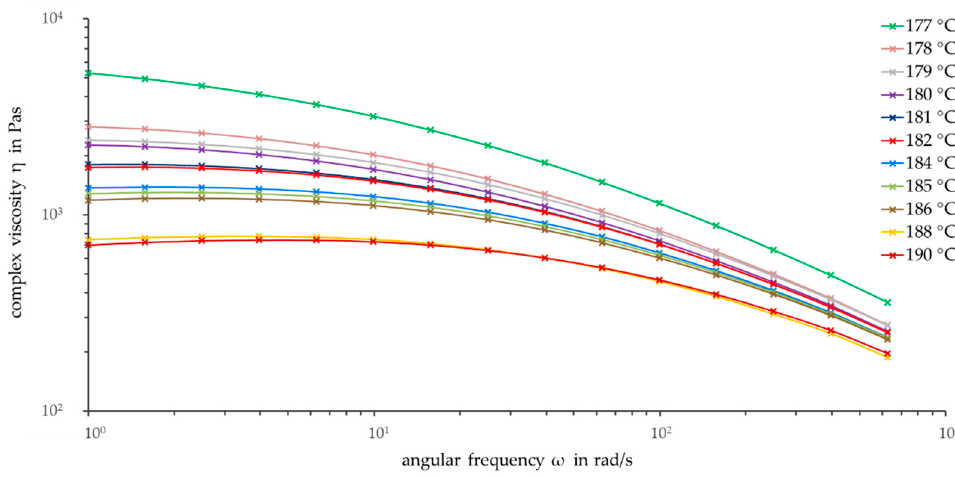
Figure 3. Frequency sweeps at different temperatures ( ϑ = 177–190 °C, ω = 1–628